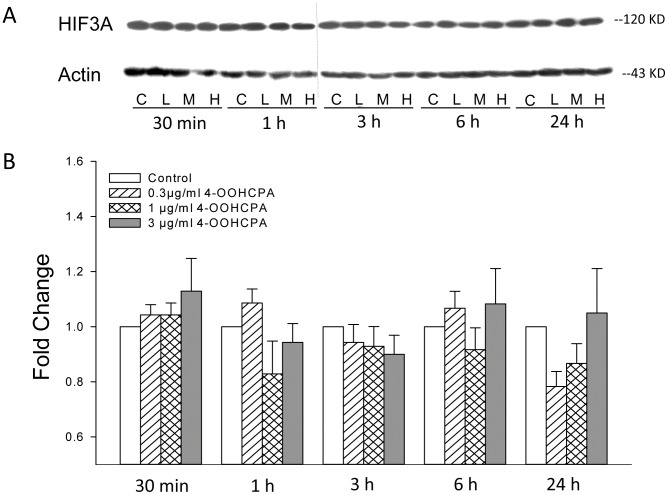
Western blot of HIF3A.HIF3A protein was detected in control limbs at all time points. A: Western blot analysis of HIF3A protein (118 KD) and actin (43 KD) in limbs at 30 min, 1, 3, 6, and 24 h after treatment with 4-OOHCPA at 0.3 µg/ml (L) 1.0 µg/ml (M) or 3.0 µg/ml (H). B: Densitometric quantification of HIF3A in drug treated groups compared to control groups. Hatched bar: 0.3 µg/ml (L), cross-hatched bar: 1.0 µg/ml (M) and gray bar: 3.0 µg/ml (H). HIF3A protein concentrations were not affected by drug treatment or time. Each bar (mean ± SEM) represents six to seven replicates.